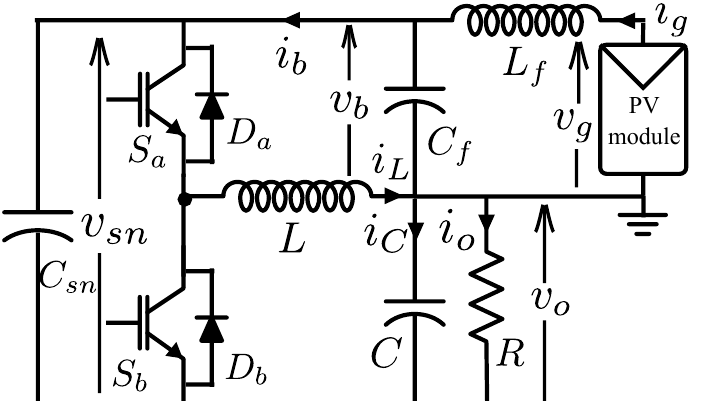
Figure 10. Circuit diagram of the buck-boost converter topology along with input and output